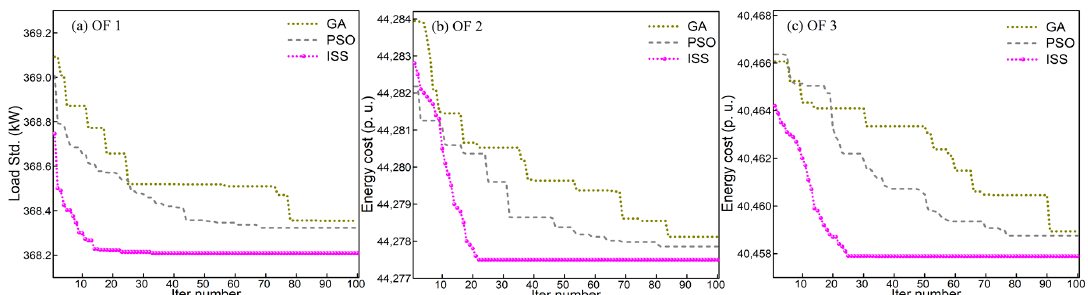
Figure 7. Iteration map for single EV with different objectives under CD-F mode. ( Left ) Load standard deviation with OF1; ( Center ) Energy cost with OF2; ( Right ) Energy cost with OF3.